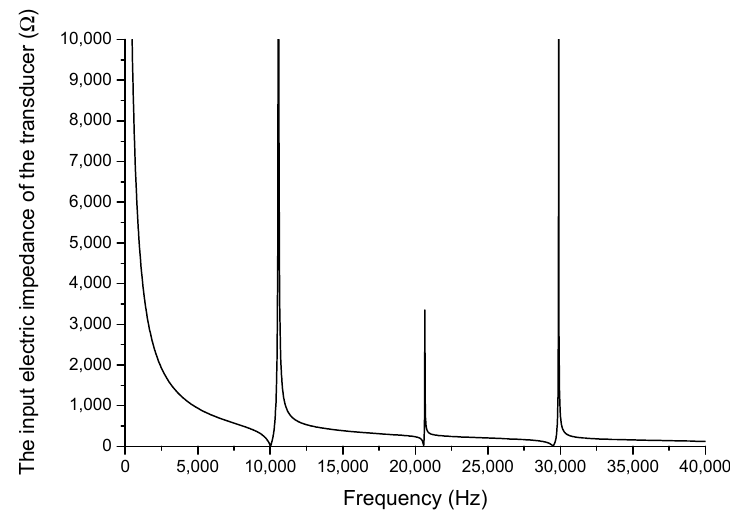
Figure 6. The frequency curve of the input electrical impedance of the cascaded piezoelectric ultrasonic transducer.